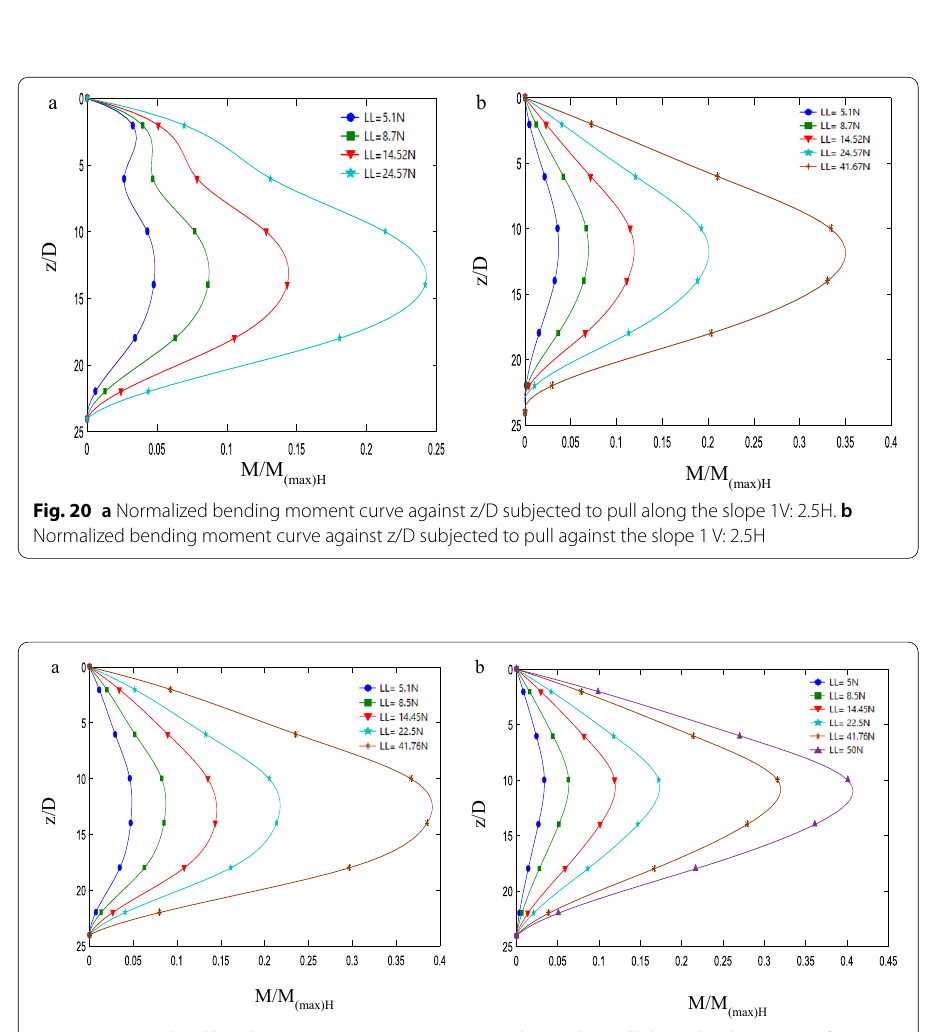
Fig. 21 a Normalized bending moment curve against z/D subjected to pull along the slope 1V: 3H. b Normalized bending moment curve against z/D subjected to pull against the slope 1 V: